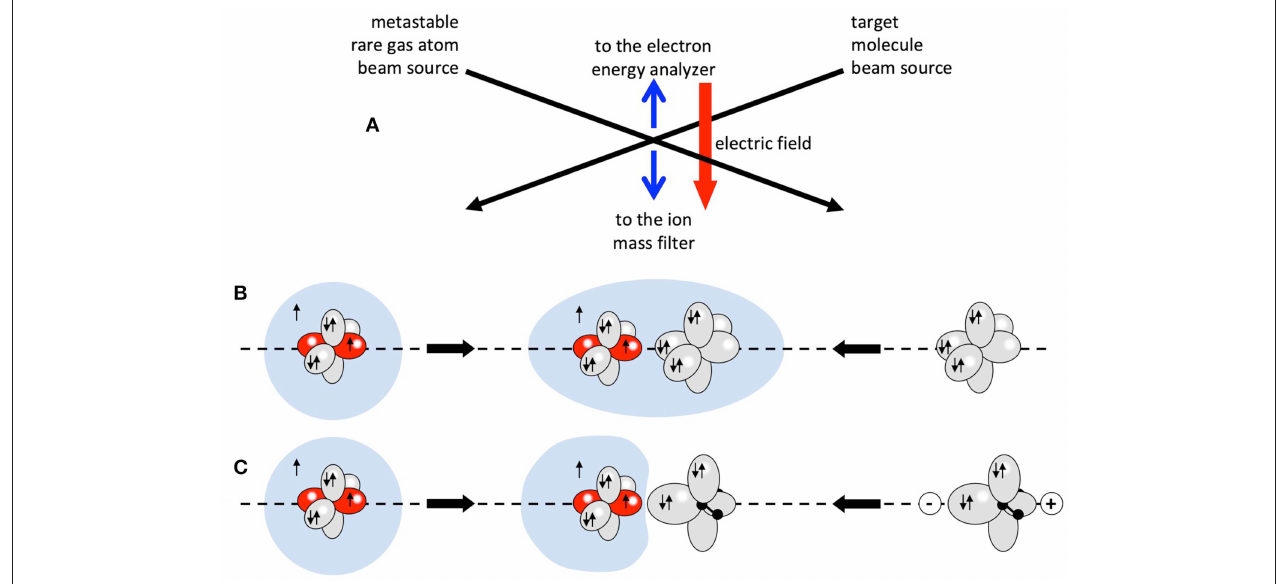
FIGURE 1 | The scheme (A) represents a typical molecular beam study for Penning ionization: a beam of metastable rare gas atoms is crossing a beam of target molecules. Product ions and electrons are extracted from the crossing volume by an appropriate electric field. The cartoons in (B,C) schematically show the collision complex in the ionization of a rare gas atom and the water molecule, respectively, where H 2 O is oriented with the negative charge toward the metastable